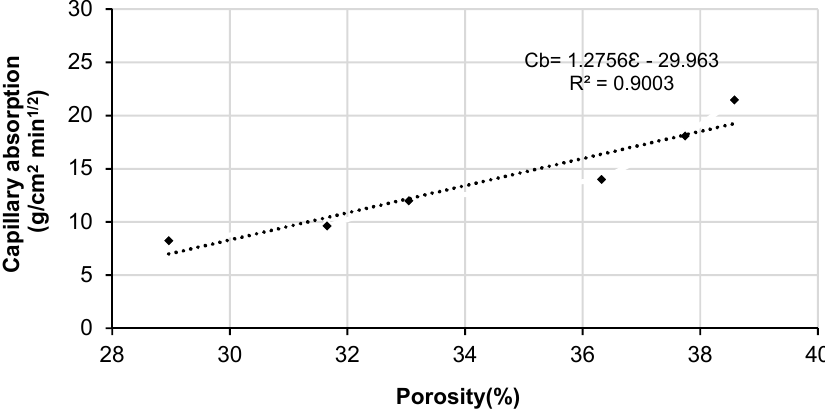
Figure 11. Water absorption by capillary as a function of the porosity of CEBs.